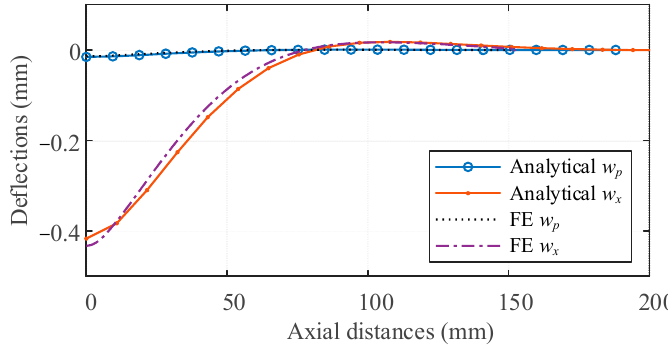
Figure 5. Comparison between the analytical and FE results.